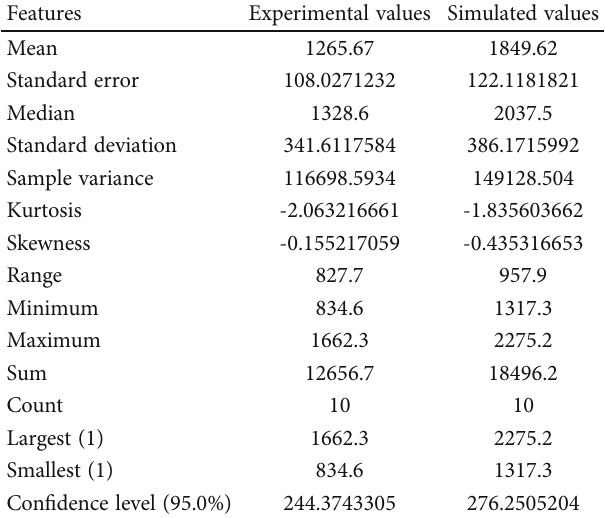
Table 5: Statistics (extracted features) based on performance analysis of monoperk